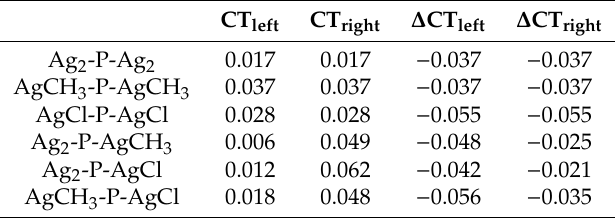
Table 7. Charge transfer (CT, e) in each coinage-metal bond in the ternary system and its change ( ∆ CT, e) relative to the binary system. CT